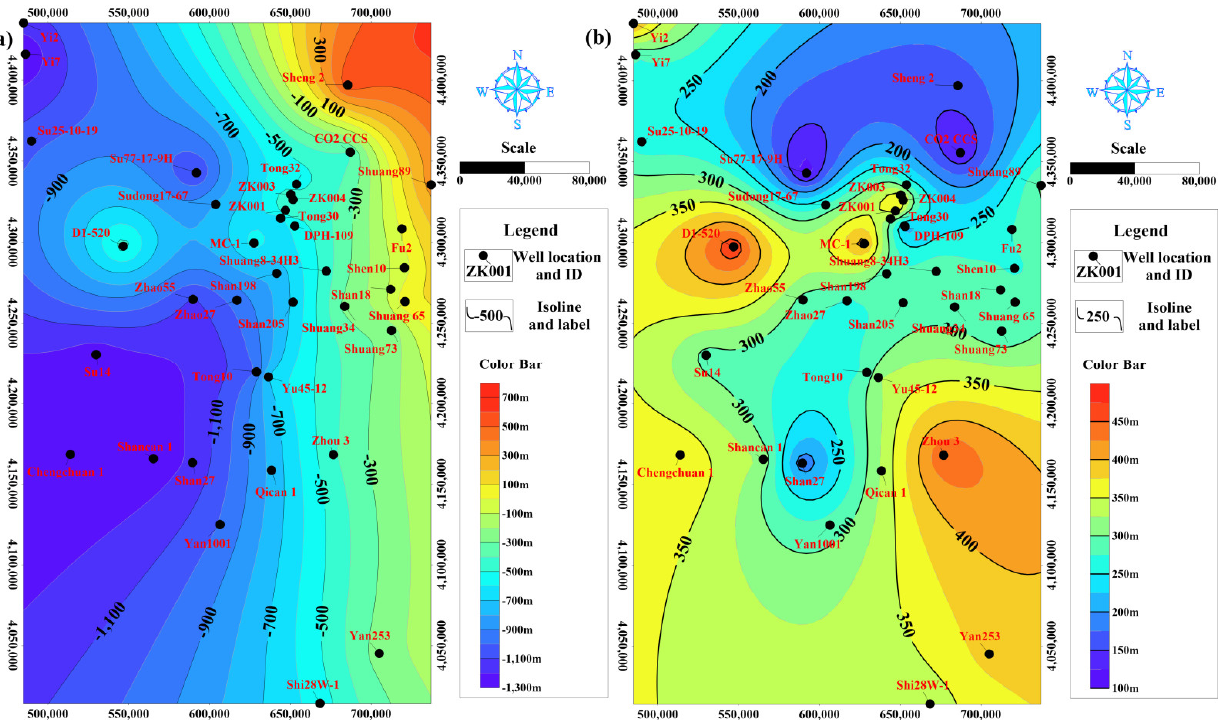
Figure 3. ( a ) The top boundary elevation of LFm. ( b ) The thickness isoline of LFm in the study area. The identified 37 wells were located at the eastern margin of the Ordos basin.